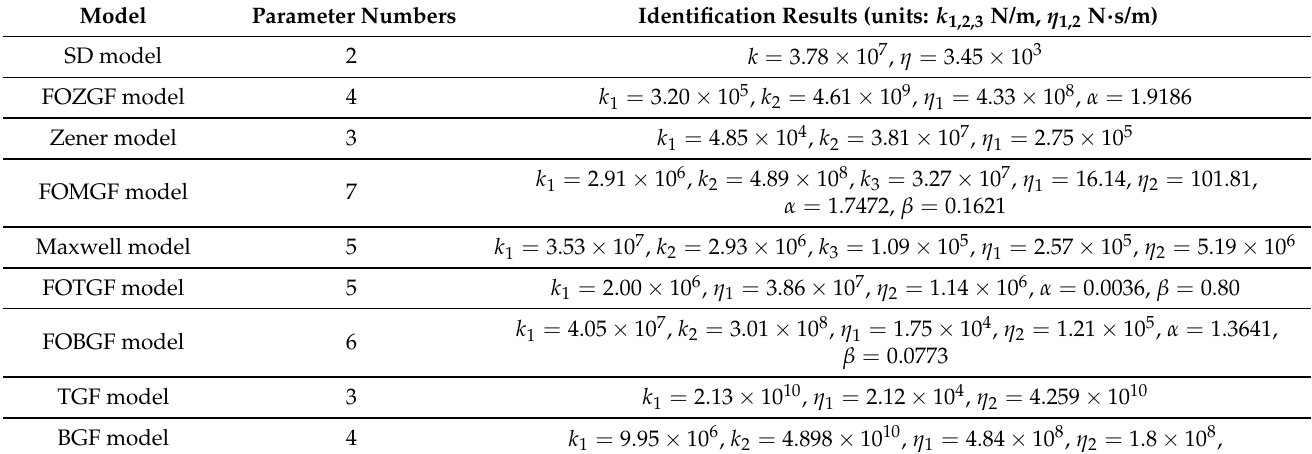
Table 1. Parameter identification results of different models.